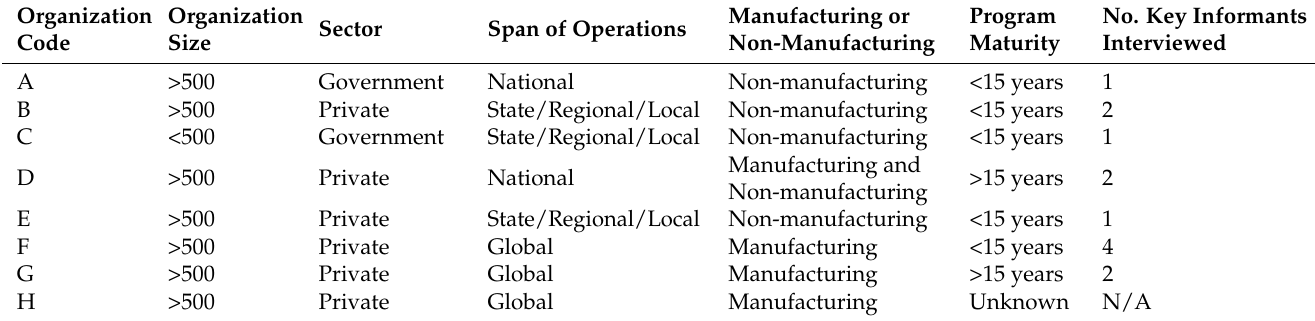
Table 1. Characteristics of the Selected Promising Practice